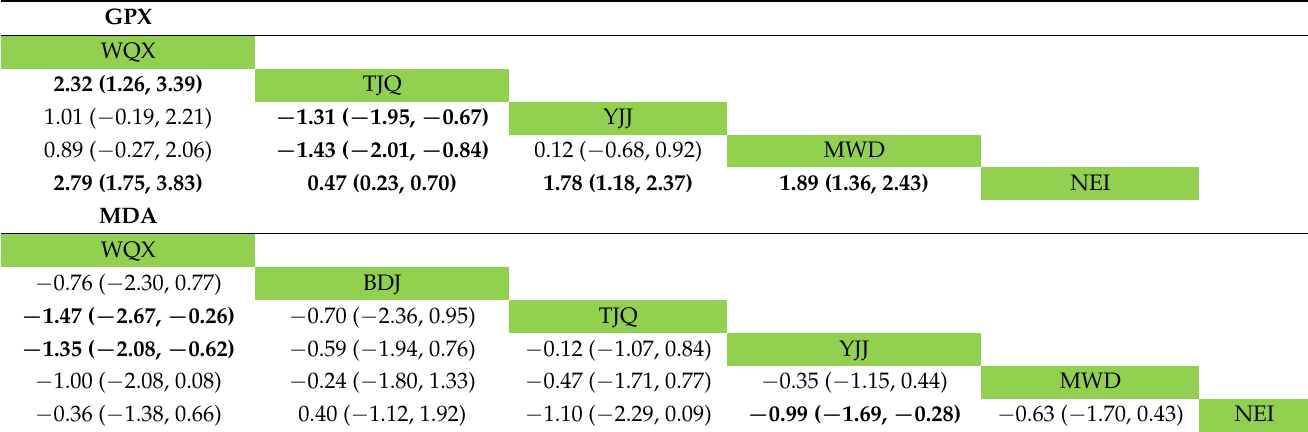
Table 2. Results of network